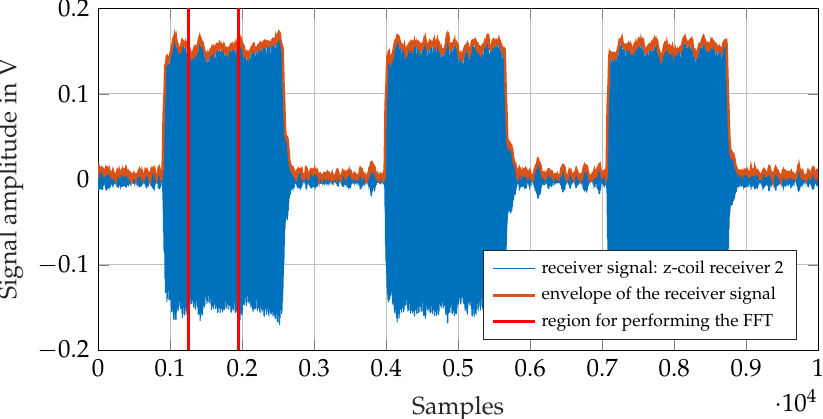
Figure 14. Receiver signal: signal at the z-coil of the receiver 2.